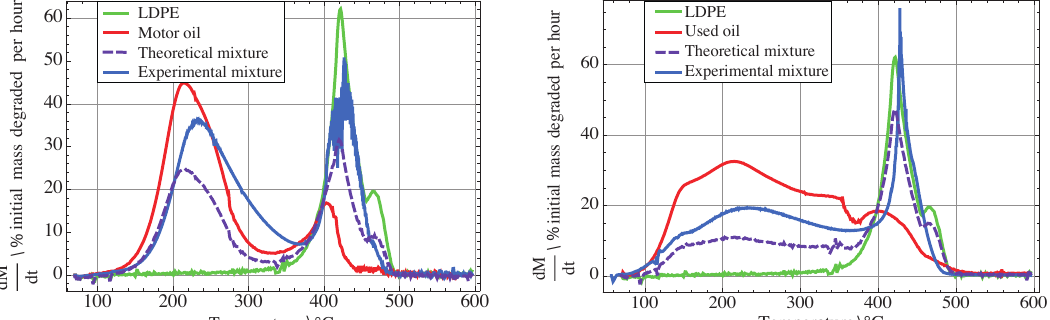
Figure 2. Thermogravimetric analysis of LDPE, motor oil, used oil and the two mixtures of oil and plastic, with a heating rate of 10 ◦ C · min − 1 . Time derivative of the mass of the sample (expressed as the % of the initial mass degraded per hour), as a function of the temperature. Left column: mixture of LDPE and motor oil (45 wt% of LDPE). Right column: mixture of LDPE and used oil (67 wt% of